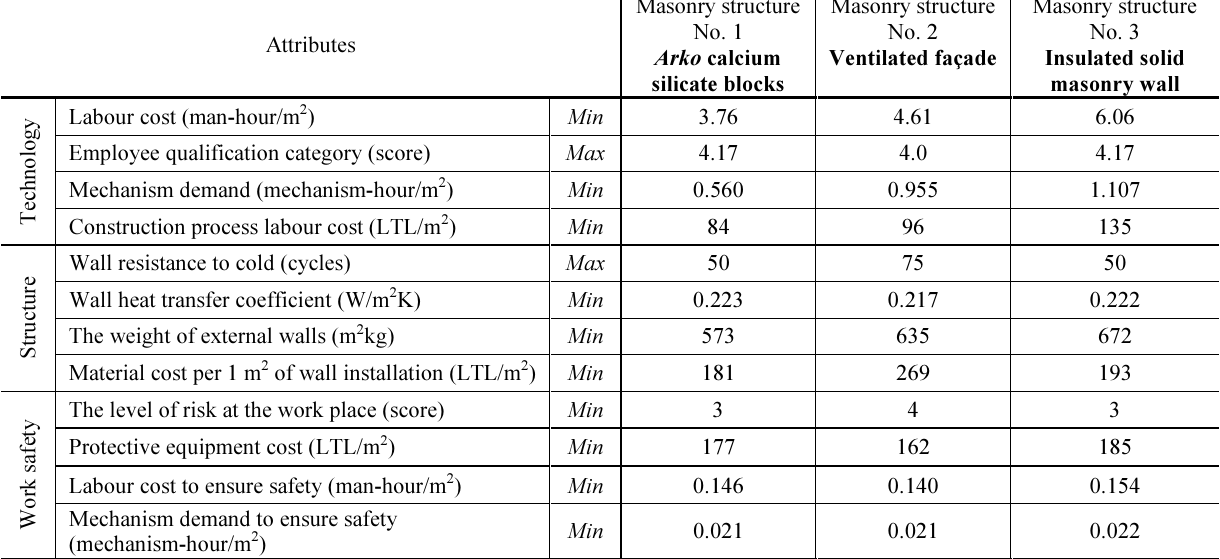
Table 2. The values of the attributes of evaluated external wall construction variants